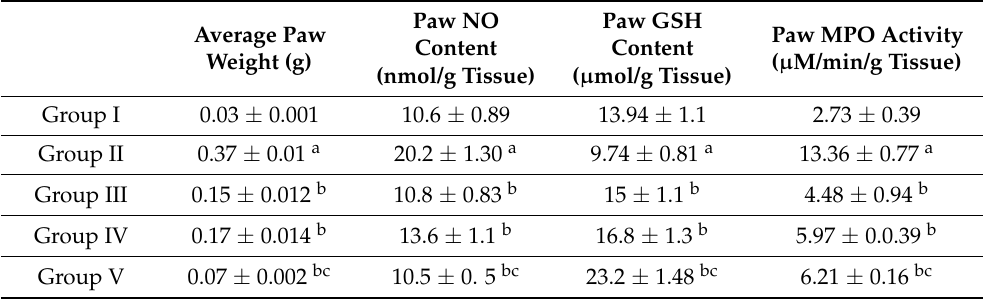
Table 4. Effects of YGME on the average paw edema weight, NO, GSH, and MPO activity in carrageenan-induced acute inflammation in